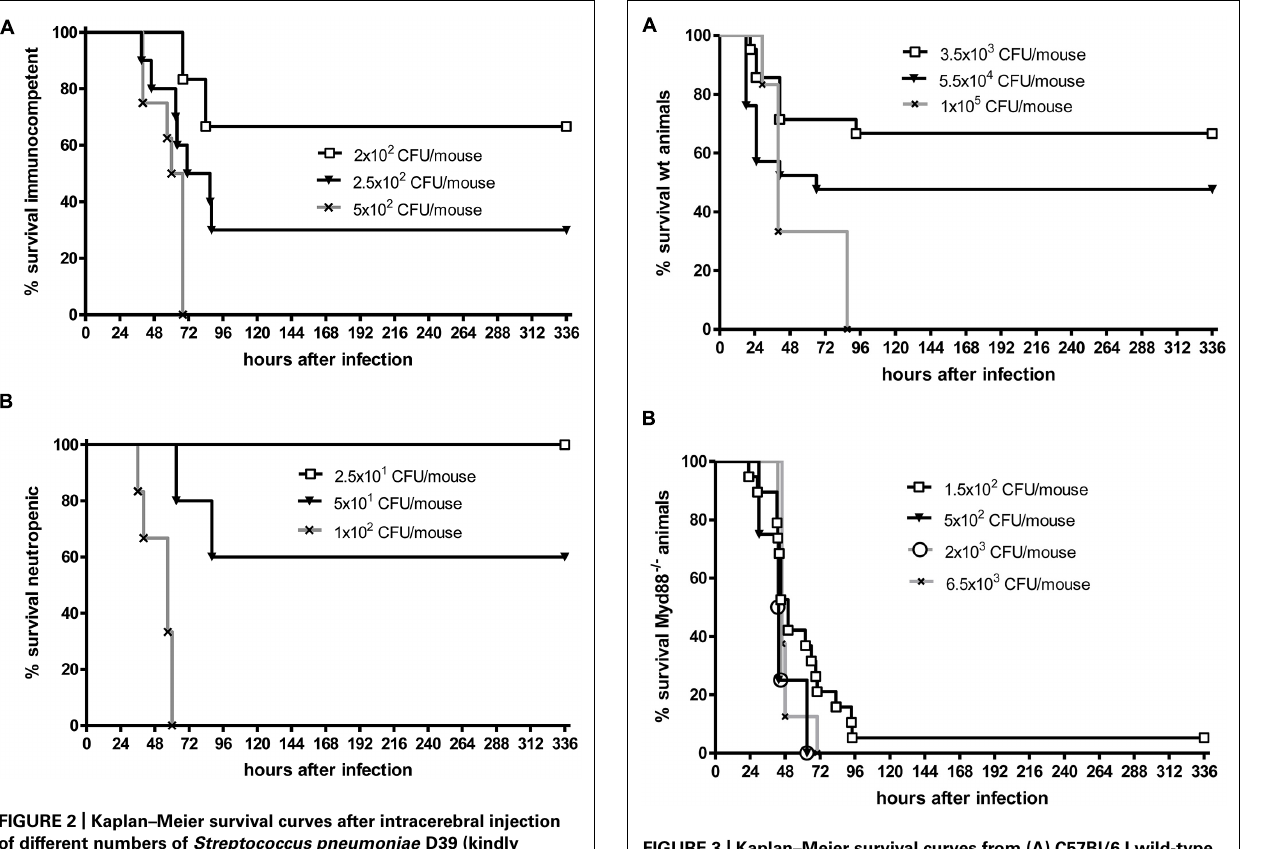
in various organs during the acute stage of infection. While